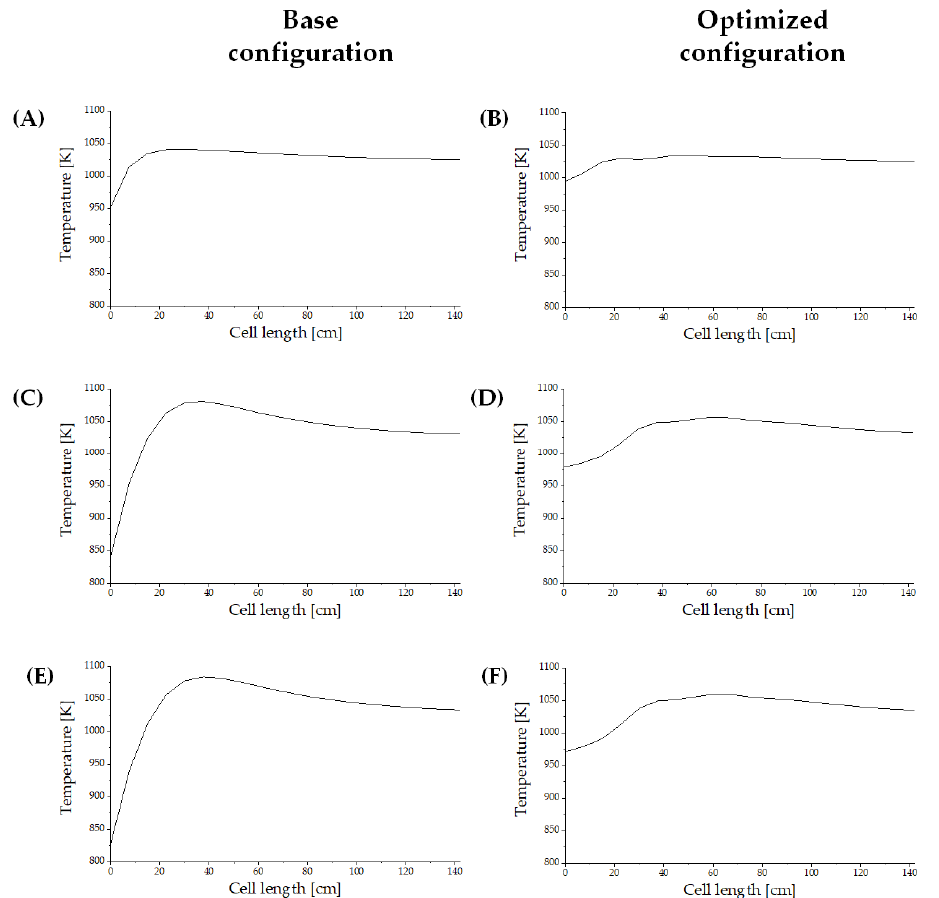
Figure 6. Temperature profile along the cell from anode inlet to anode outlet at different distances from the cathode inlet for the kinetics base case ( A , C , E ) and the optimized approach ( B , D , F ) in correspondence with the cathode inlet ( A , B ), in the middle between cathode inlet and outlet ( C , D ), and in correspondence with the cathode outlet ( E , F